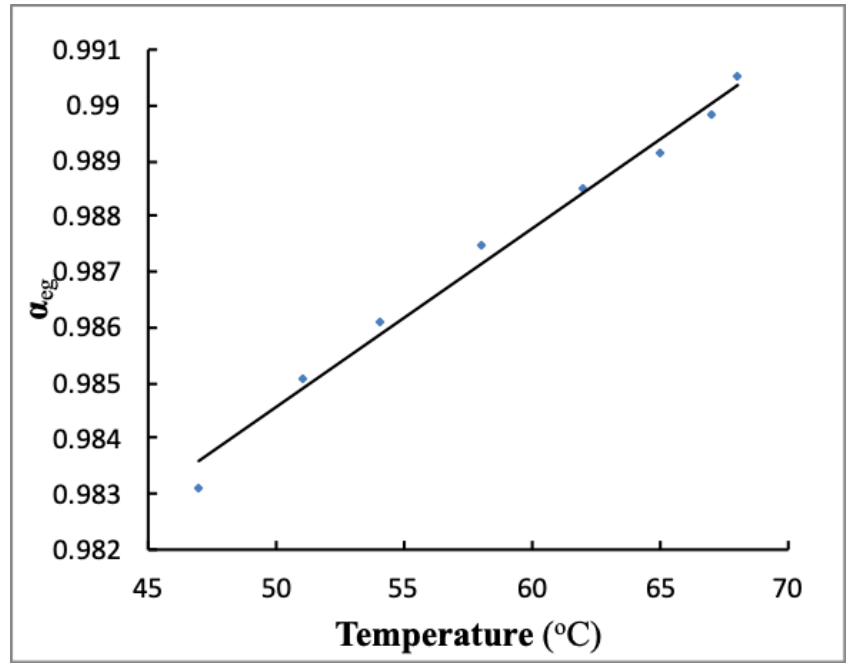
Figure 5. The parameter of effective geometry α eg varies with temperature for the investigated compound, I .